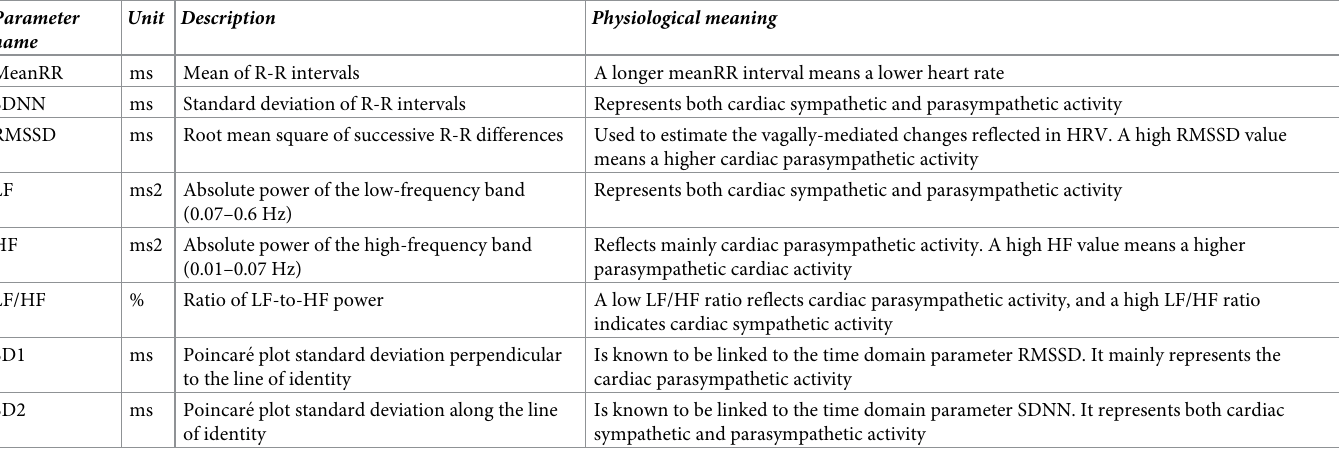
Table 1. Name, unit, description, and physiological meaning of the HR and HRV parameters included in the present study (modified from Shaffer et al,